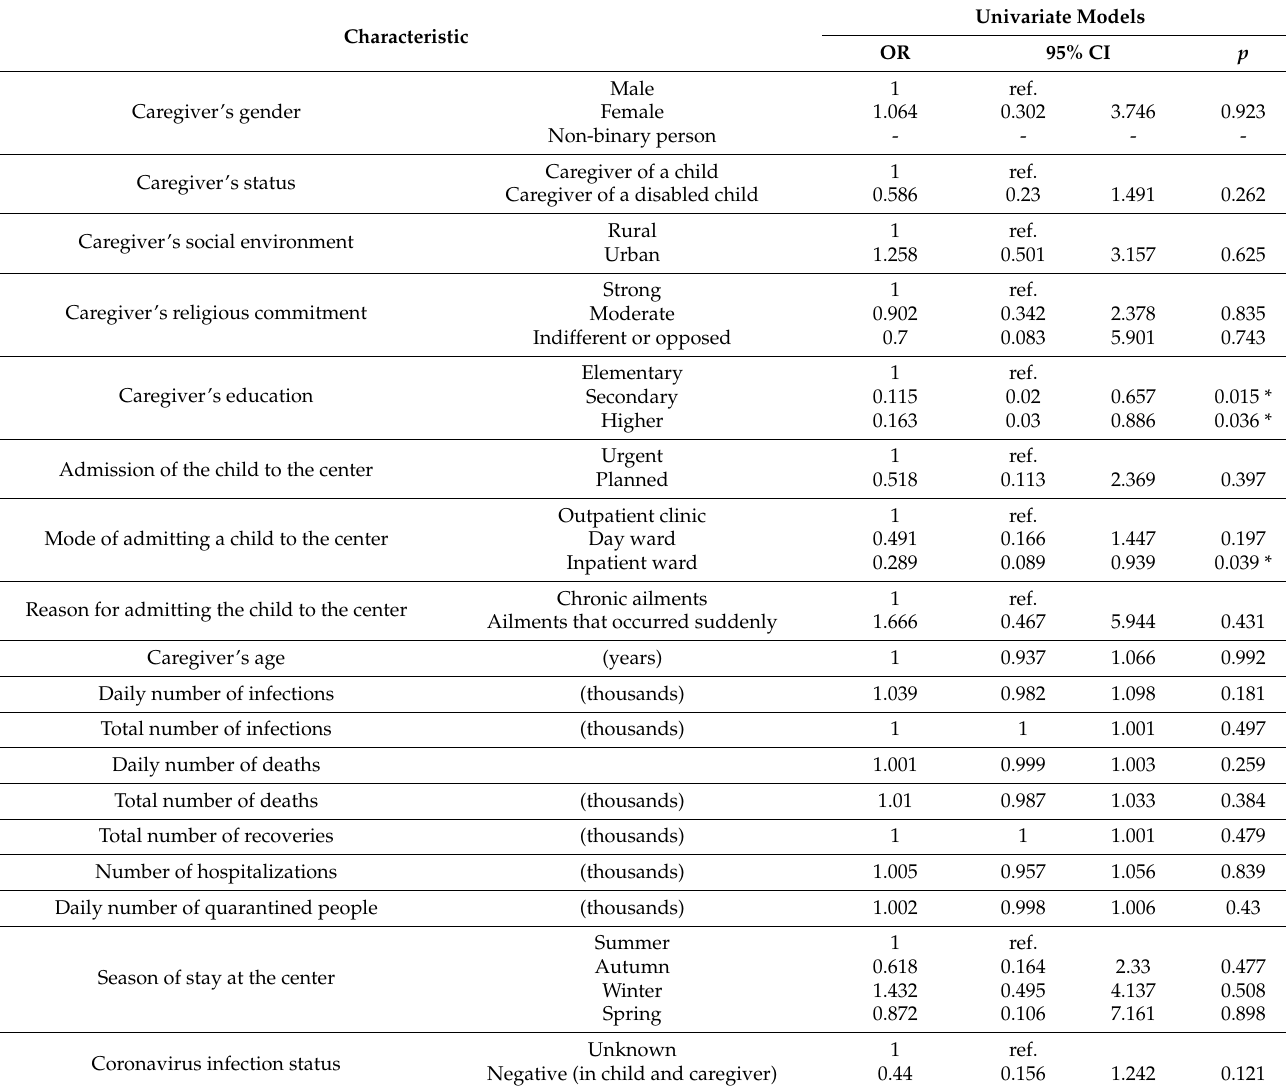
Table 12. Predictors of the co-occurrence of anxiety and depression: univariate analysis. Characteristic